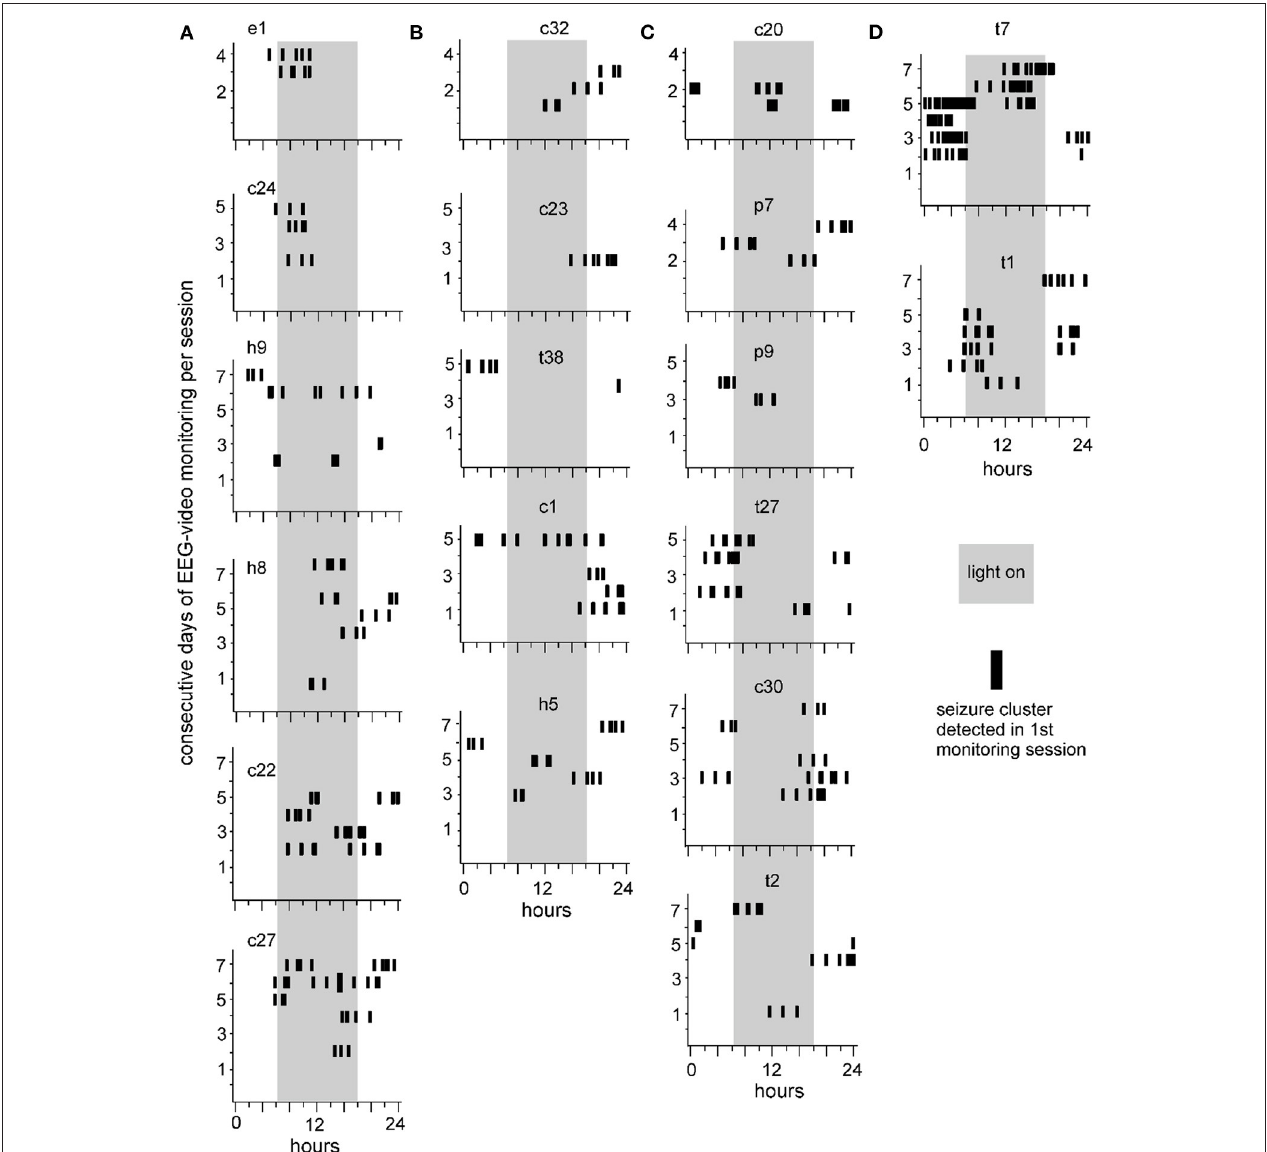
FIGURE 4 | Seizure clusters recognized during the first session of 24-h EEG-video monitoring. Data collected from 19 mice are presented in individual plots. Mice are indicated by small letters and numbers, with “c, e, h, p, or t” standing for unstimulated cortical, entorhinal, hippocampal, piriform, or thalamic area, respectively. Y-axis – consecutive days of 24-h EEG-video performed in individual mice. X-axis – 24h of the day. Long gray bars – the light-on period (6 am to 6 pm). Short black vertical bars – seizure clusters recognized at times of consecutive days. (A,B) Seizure clusters were observed largely in the light-on (A) or light-off (B) period. (C) Seizure cluster expressions in both the light-on and light-off periods. (D) Seizure clusters with relatively confined expression in the light-on or light-off